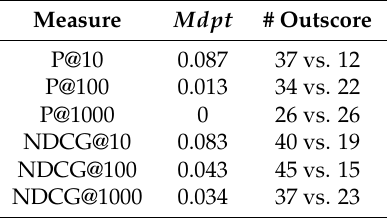
Figure 24. T2: scatter plots of P@10 and NDCG@10 of NoPorterNoStop/DirichletLM vs. RR fusion of best runs per model with QE+RF: ( a ) P@10, ( b ) NDCG@10. Table 22. T1: Porter/DirichletLM+QE+RF run vs. RR fusion of models using Porter index.